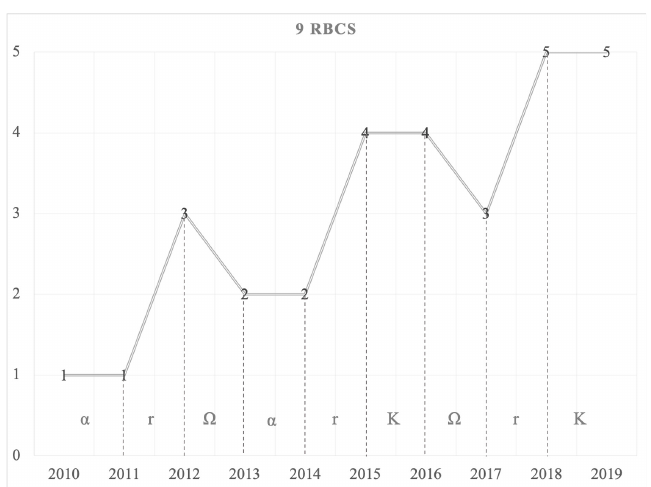
Figure 8. Resilience dynamics of overall resilience values of 9 RBCs from 2010 to